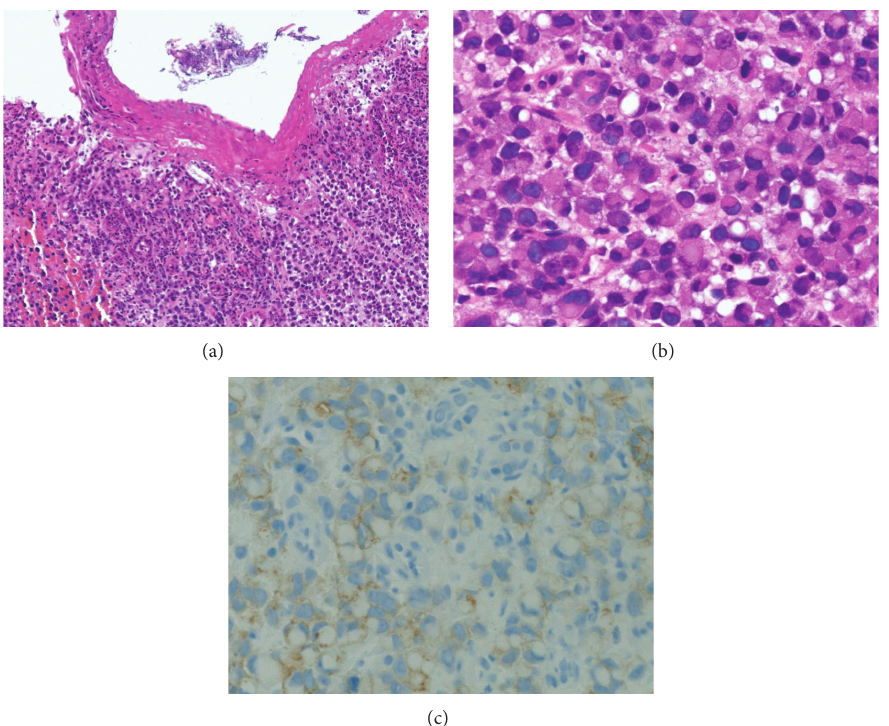
Figure 4: (a) Poorly differentiated adenocarcinoma of the gastric cardia. Histologic sections demonstrate erosion of the surface epithelium with diffuse involvement of the lamina propria by an atypical infiltrate comprised predominantly of discohesive cells ((a), 10x). (b) Poorly differentiated adenocarcinoma of the gastric cardia. On high power (40x), the cells in the infiltrate demonstrate prominent signet ring cell morphology, diagnostic of poorly differentiated adenocarcinoma. (c) Poorly differentiated adenocarcinoma of the gastric cardia. An immunohistochemical stain for HER2 interpreted as being equivocal ((c),